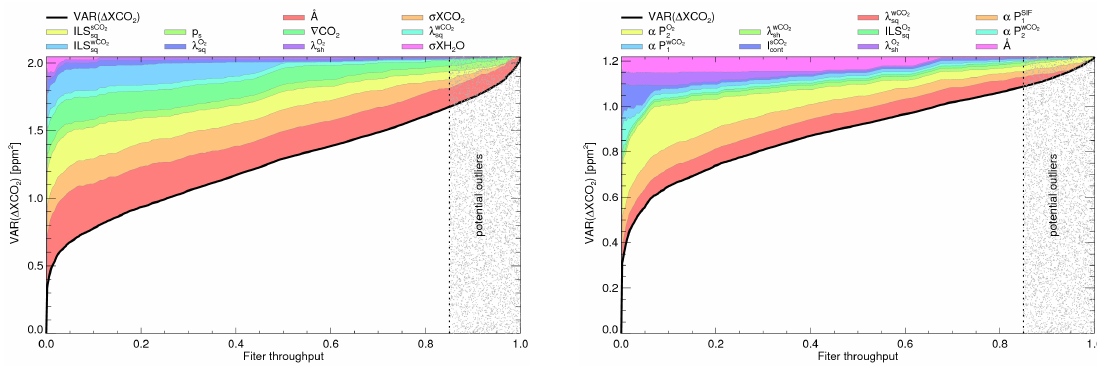
Figure 8. Variance versus filter throughput for the 10 most promising parameters identified for the potential outliers filter. The colors represent the prorated variance reduction of the individual parameters. See part1 [23] and the main text for a description of the individual parameters. ( left ) Land; ( right )